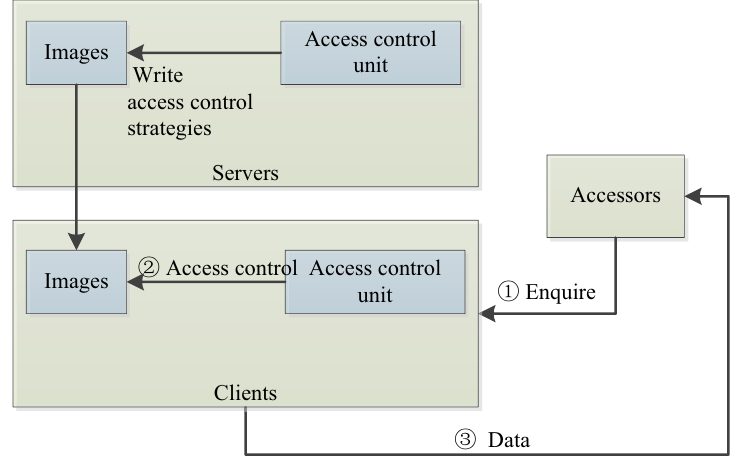
Figure 2. Existing traditional access control